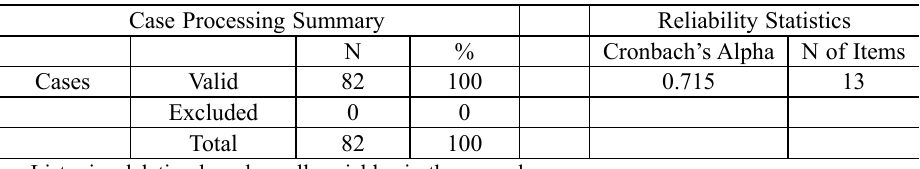
Table 1. Data Reliability Test (Cronbach’s